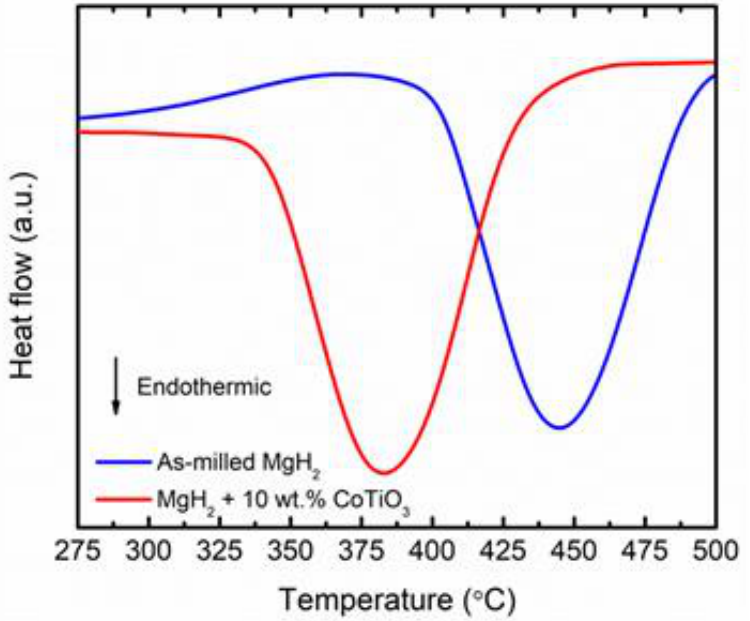
Figure 5. Thermal event of as-milled MgH 2 and MgH 2 + 10 wt.% CoTiO 3 (Heating rate: 30 °C/min) under 50 mL/min of Argon flow.